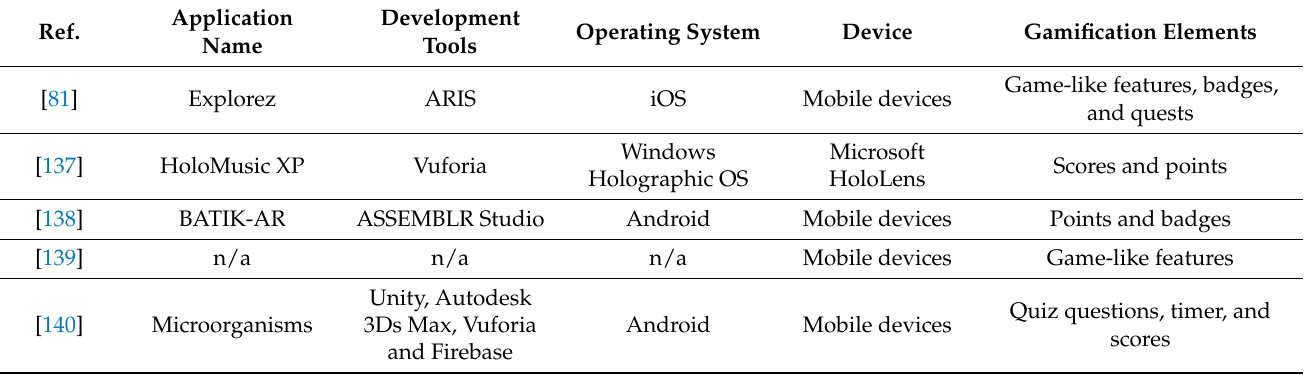
Table 3. Empirical studies: Application development information and gamification elements.